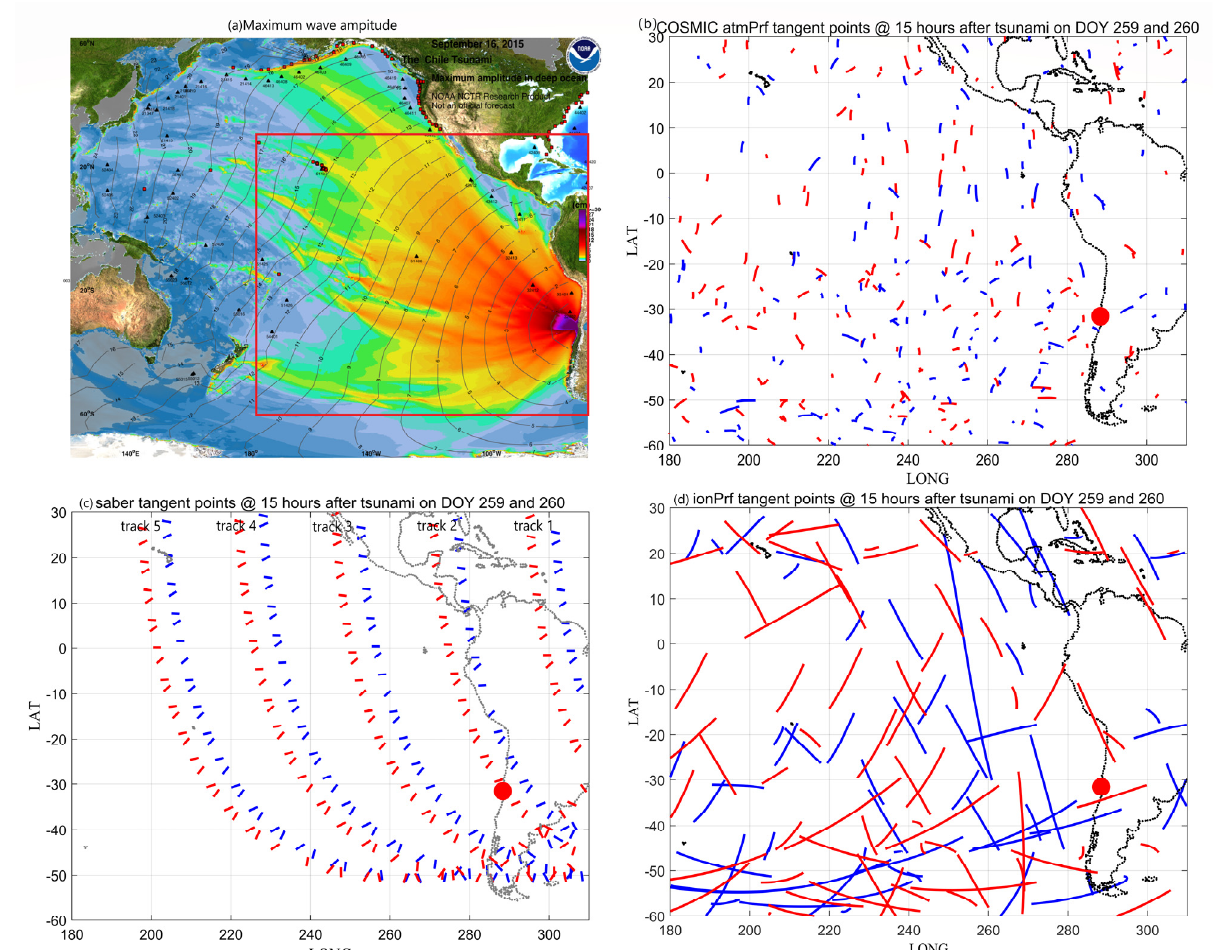
Figure 1. Data sources of the 16-09-2015 Chile tsunami. ( a ) Maximum wave amplitude with travel- time contours of the tsunami. Filled colors show the maximum computed tsunami amplitude in cm during 24 h of wave propagation (https://nctr.pmel.noaa.gov/chile20150916/ (accessed on 1 July 2022)). The red rectangular box marks the main focus area of this study. ( b – d ) The projections of the tangent points 15 h after the tsunami for the F3/C atmPrf, SABER, and F3/C ionPrf datasets, respectively. Blue and red curves mark the ground track of the tangent point location on DOY 259 and 260 of 2015, respectively. The thick red point shows the